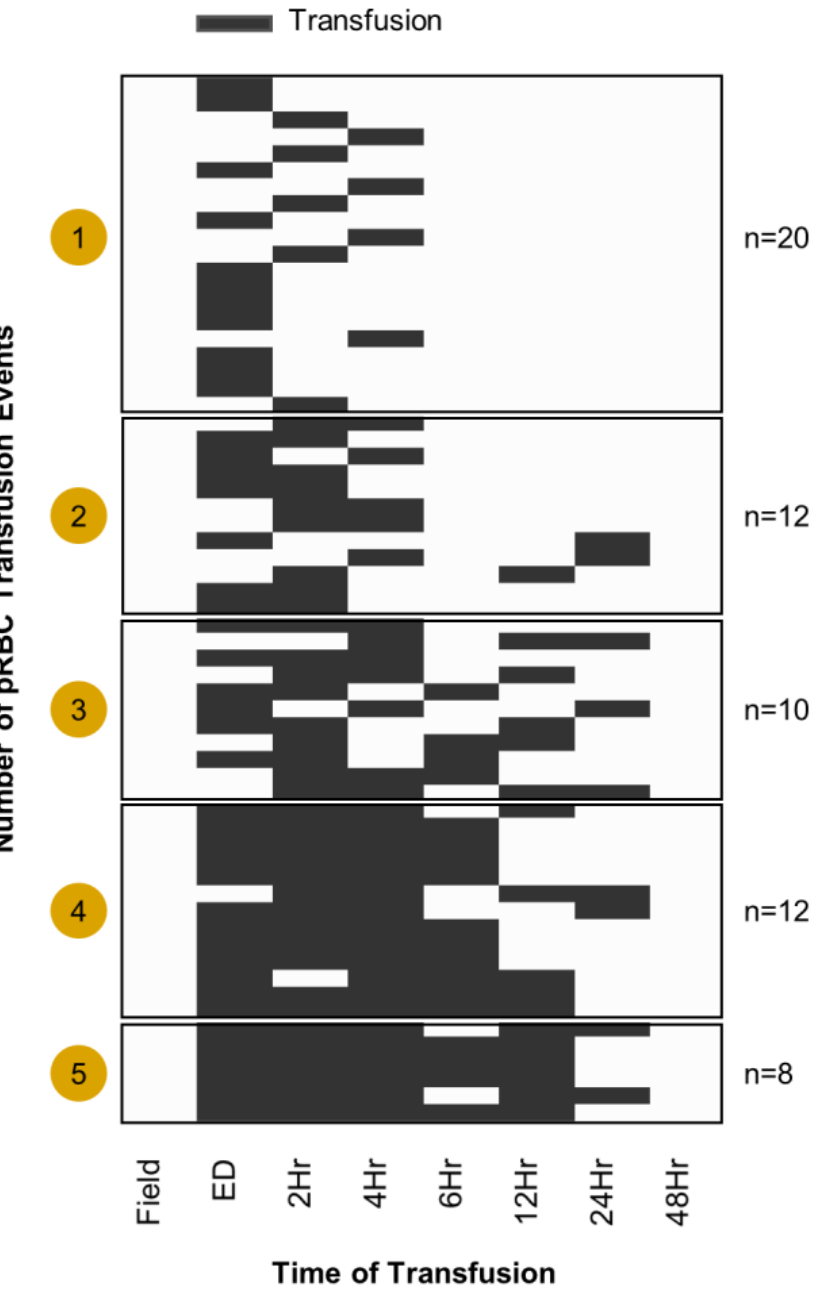
Figure 3. Heat map of patients that received transfusions during the time course. Black coloring represents when a transfusion took place. Patients were grouped by the number of transfusion events where “events” ranged from one to five transfusions.